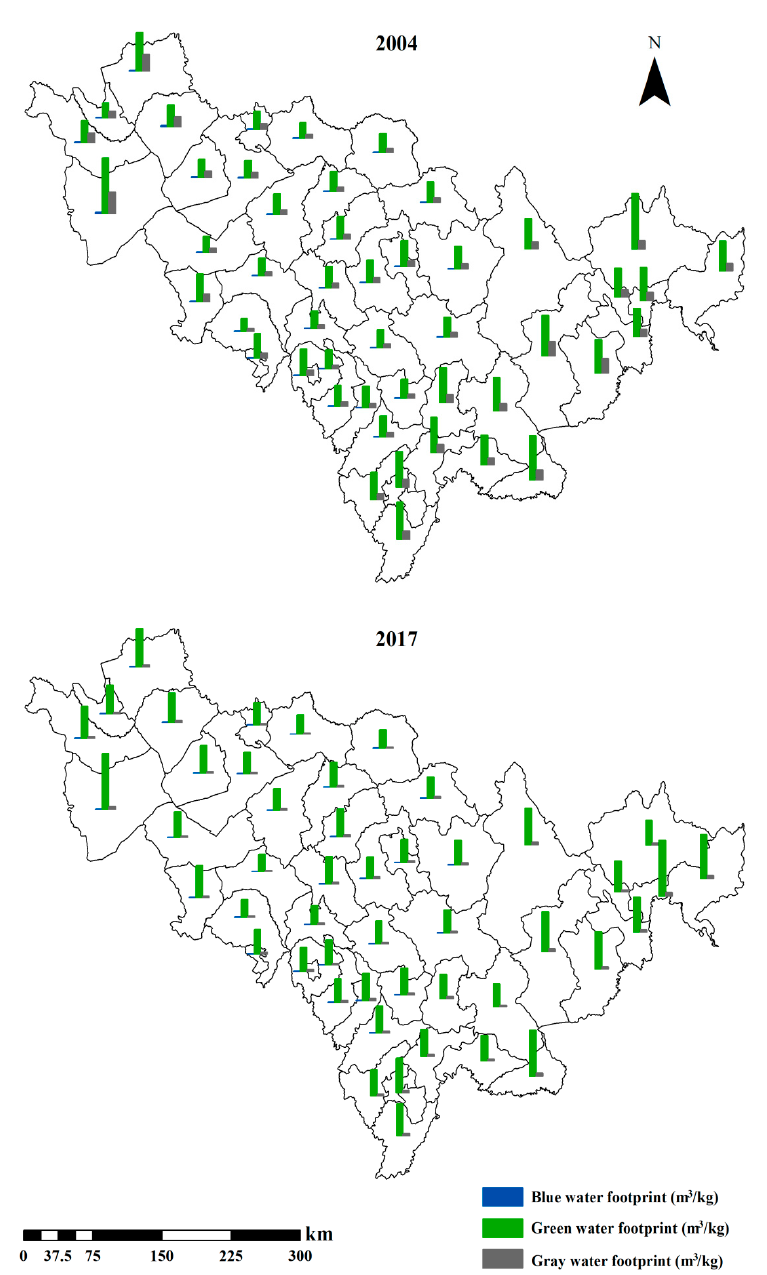
Figure 8. Spatial distributions of the blue, green and gray WFs in Jilin Province in 2004 and